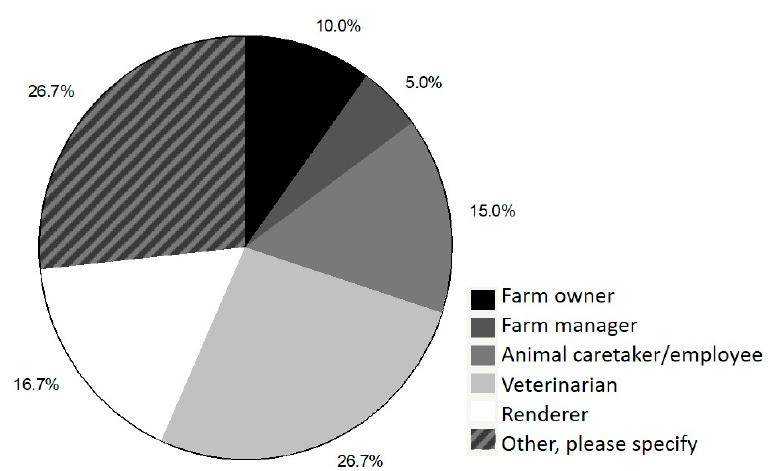
Figure 1. Responses of survey respondents who indicated that they were not the primary party responsible for making euthanasia decisions and were asked to specify the role of the individual who makes most of the euthanasia decisions.